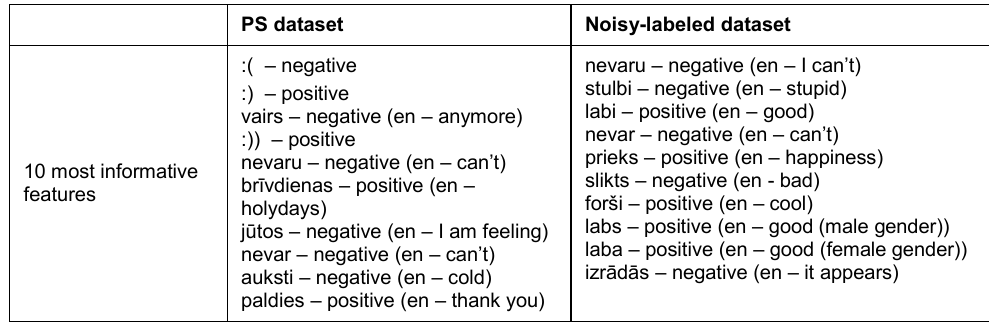
Table 5. Most informative features of PS and noisy-labeled dataset PS dataset Noisy-labeled